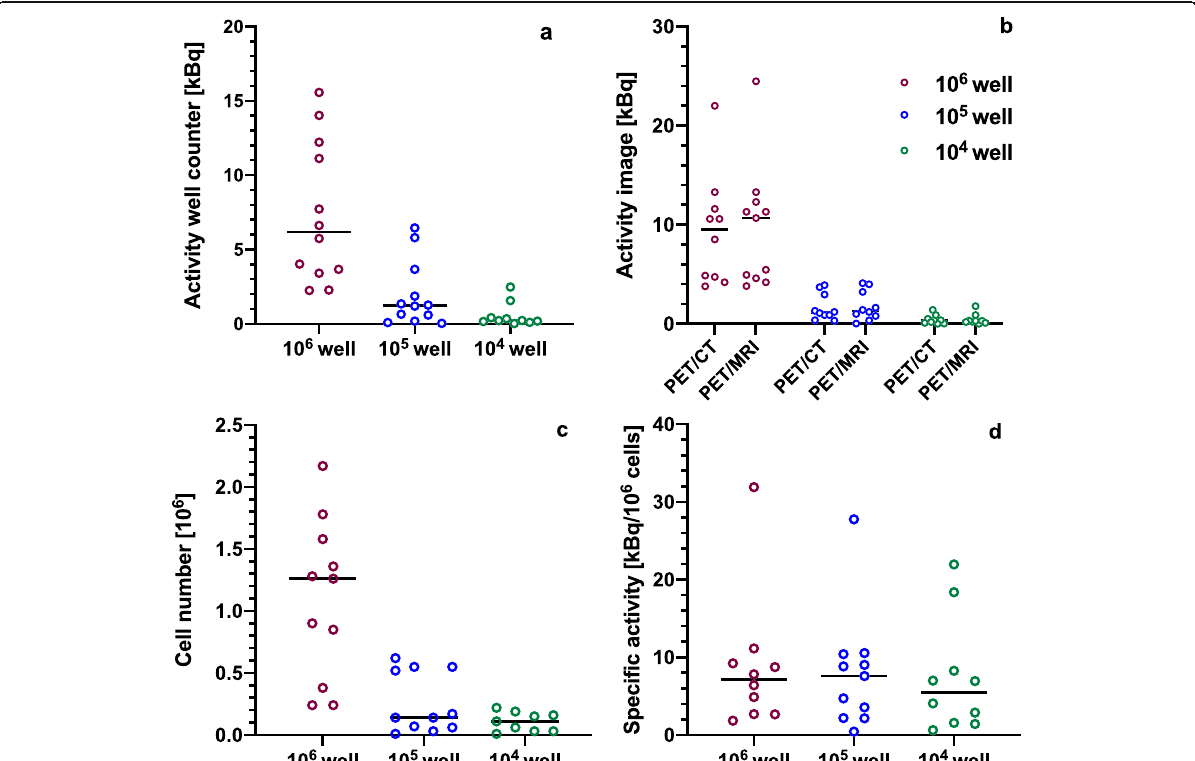
Fig. 2 Individual value plots and median of a total activity [kBq] in 10 6 , 10 5 , and 10 4 wells as measured by the well counter; b total activity [kBq] in 10 6 , 10 5 , and 10 4 wells as obtained from PET images acquired using PET/CT and PET/MRI; c cell number in 10 6 , 10 5 , and 10 4 wells; and d specific activity [kBq/10 6 cells] in different